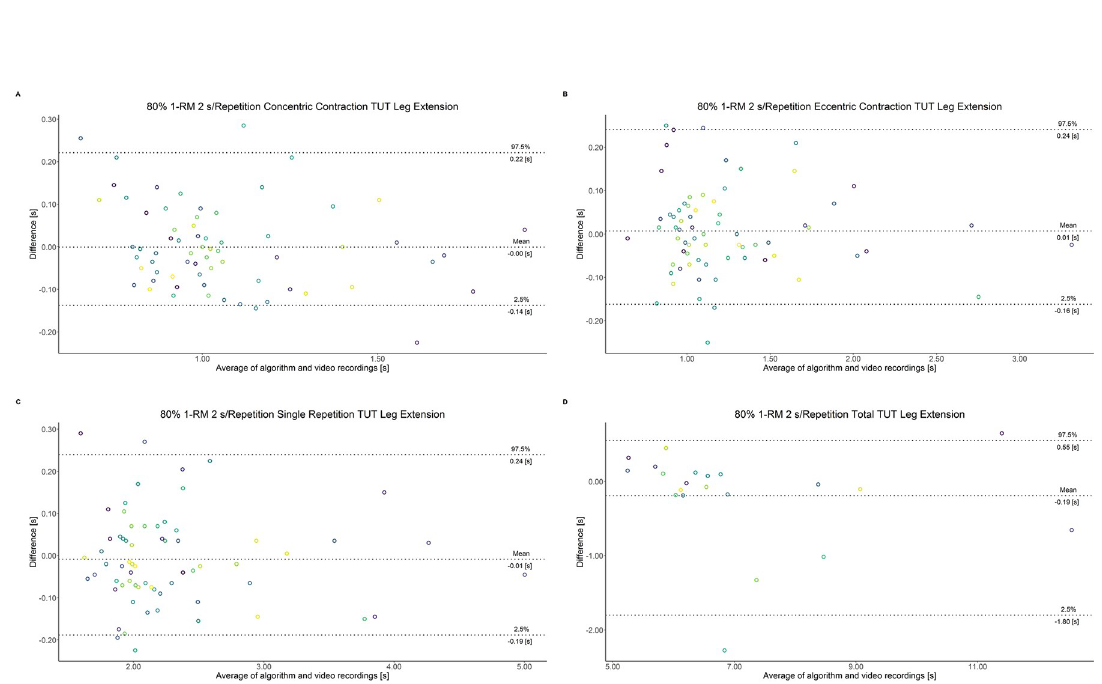
Fig 12. Bland-Altman plots of agreement between algorithmically accelerometer derived and video recordings derived contraction-specific phases of the leg extension machine at 80% 1-RM with a velocity of 2 s per repetition. A: Concentric contraction phase. B: Eccentric contraction phase. C: Single repetition. D: Total time-under-tension.